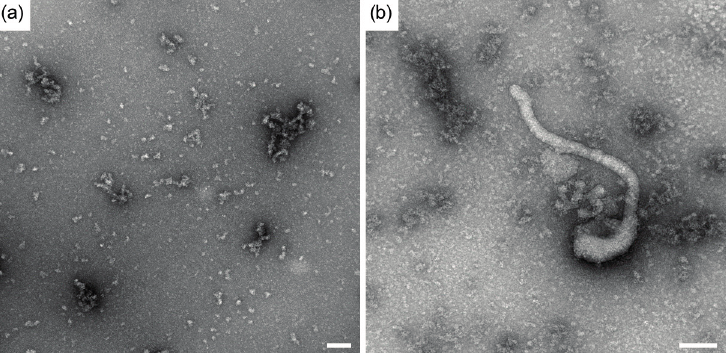
Figure 2. Transmission electron microscopy (TEM) images of inactivated Ebola Zaire virus sample showing predominance of fragmented viral particles. ( a ) A representative image of dilute samples containing the fragmented, inactivated Ebola virus; ( b ) An image of rare filamentous structures having a diameter of approximately 30 nm. Scale bars are 100